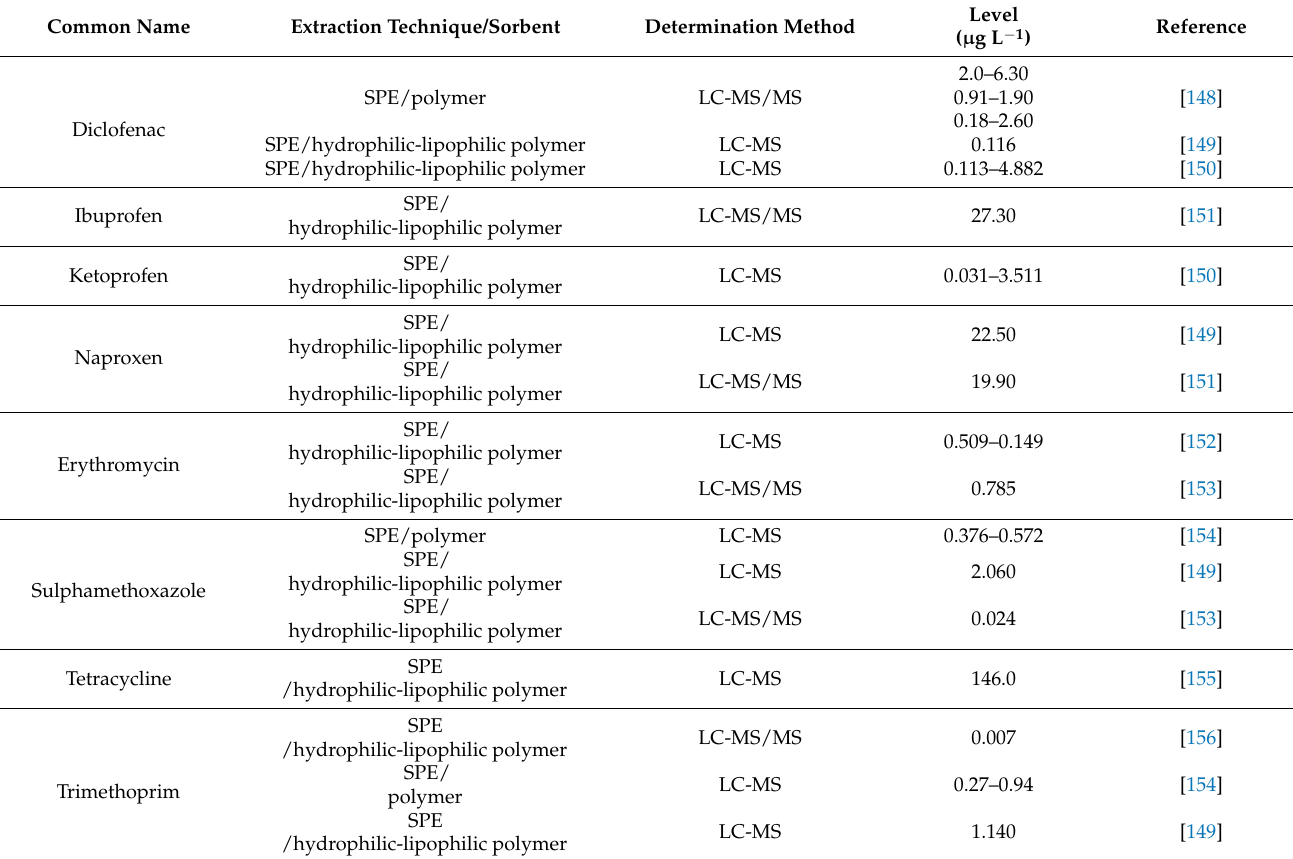
Table 5. Methods used for the extraction and determination of the analyzed